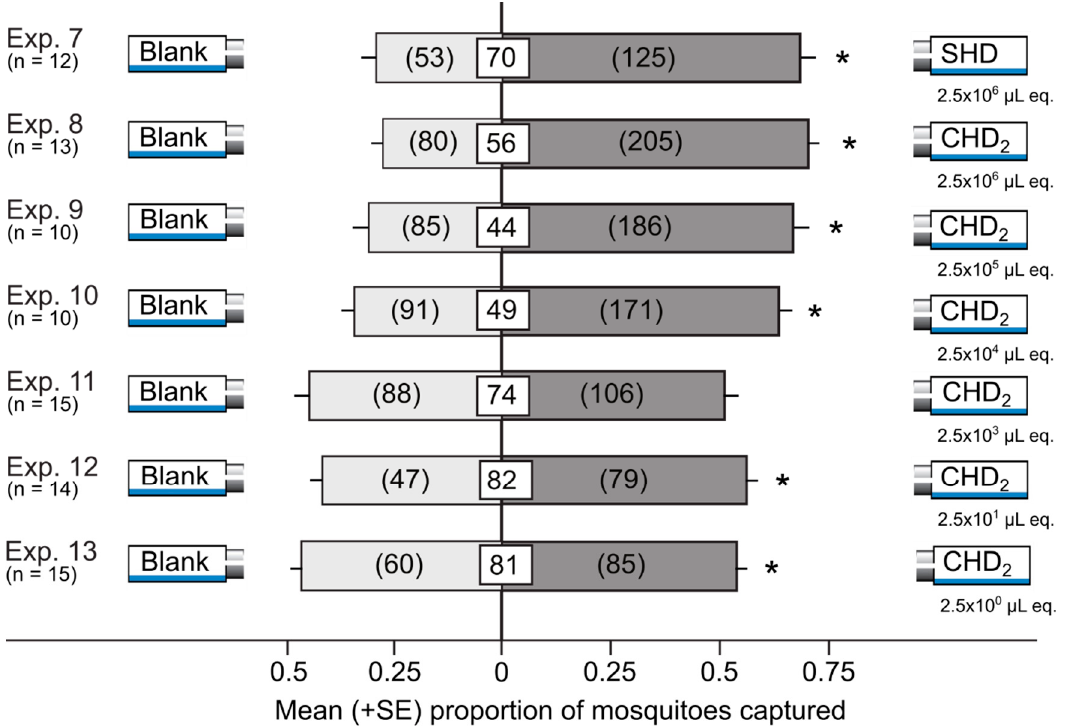
Figure 4. Mean proportion (+SE) of female yellow fever mosquitoes, Aedes aegypti , captured in Experiments 7–13 in paired traps that were baited with the SHD (a synthetic blend of sterile honeydew-derived odorants prepared according to literature data [32], Table 2) or the CHD 2 (a synthetic blend of crude honeydew-derived odorants prepared according to literature data [32], Table 2) at descending doses or that were fitted with a corresponding solvent (blank) control. Numbers in parentheses represent the total number of mosquitoes selecting a test stimulus, and numbers within white squares indicate the mean percentage of mosquitoes not captured. An asterisk (*) indicates a significant preference for a test stimulus ( p < 0.05; binary logistic regression). The dose of 2.5 × 10 1 µL equivalents (eq.) of honeydew approximates the amount of honeydew produced by 25 pea aphids per day [49].